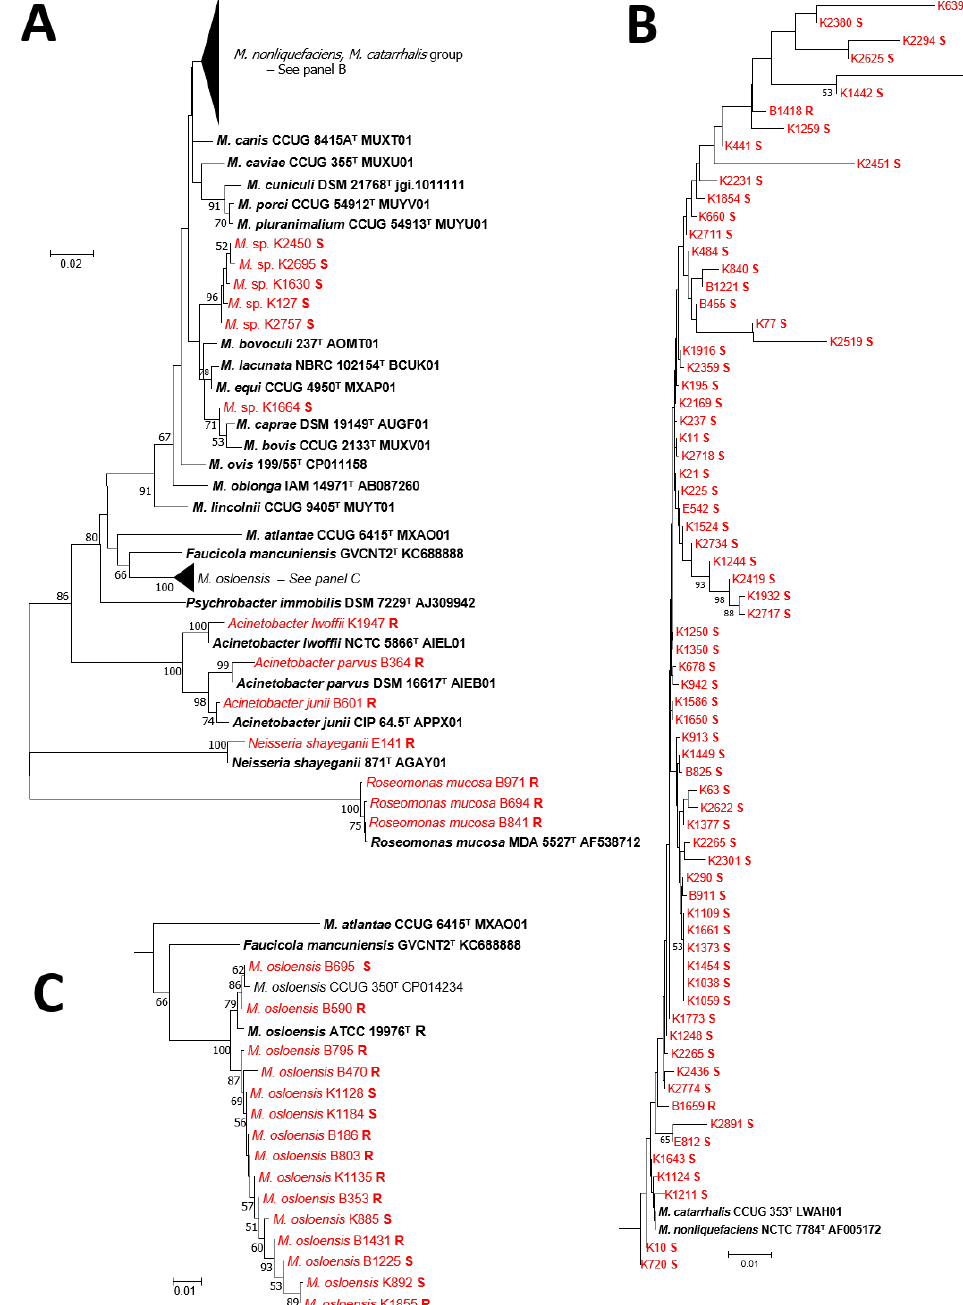
Figure 3. A diagram of the neighbor joining tree of 16S rRNA sequences for the Moraxella isolates in the study. Panel ( A ) details the neighbor joining tree (25) constructed with all sequences from this study and relevant type strains. Clades corresponding to M. nonliquefaciens / M.catarrhalis and M. osloensis are condensed. Panel ( B ) depicts clades corresponding to M. nonliquefaciens / M.catarrhalis. Panel ( C ) corresponds to M. osloensis. Red indicates strains from our clinical collection and black indicates select type strains. The vancomycin susceptibility status is indicated as S for susceptible and R for resistant.